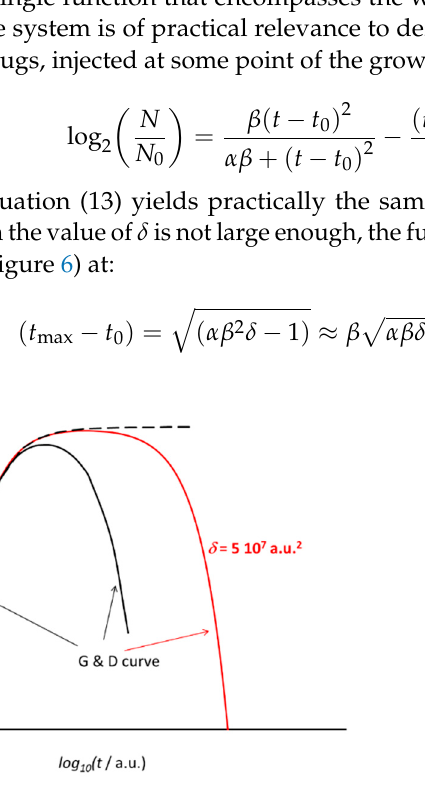
Figure 5. E. coli culture in feta cheese. Growth (black dashed line) and Decay (red dashed line) trends according to Equations (2) and (12), respectively. The insert reports the corresponding parameters, which come from the best fit of experimental data, adjusted for the log base after [14]. Time is in a log 10 scale. Bars correspond to the standard error.